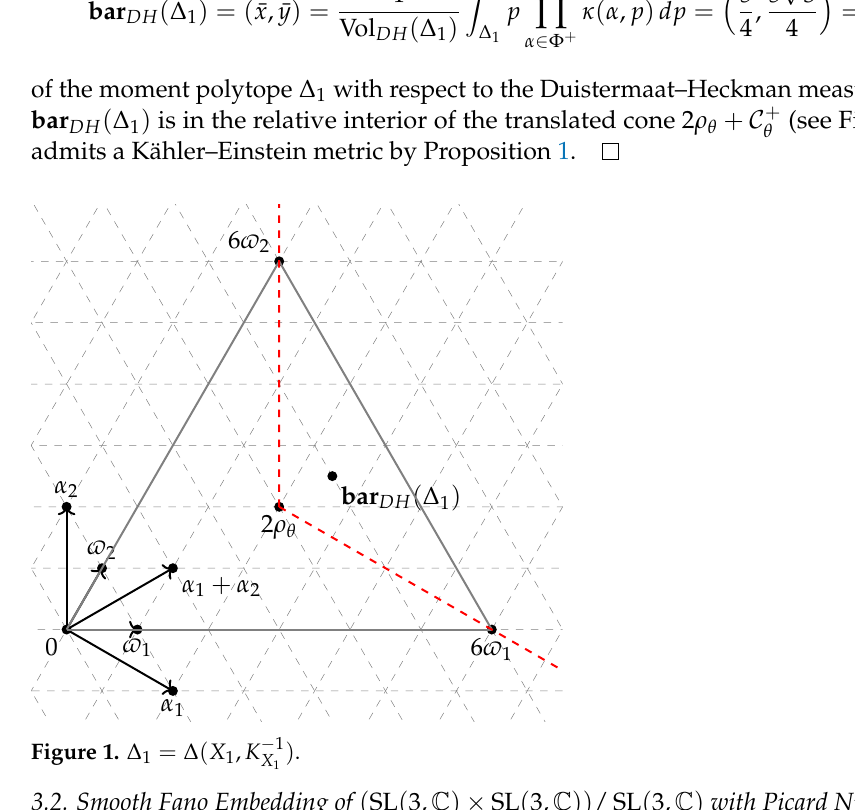
Figure 1. ∆ 1 = ∆ ( X 1 , K − 1